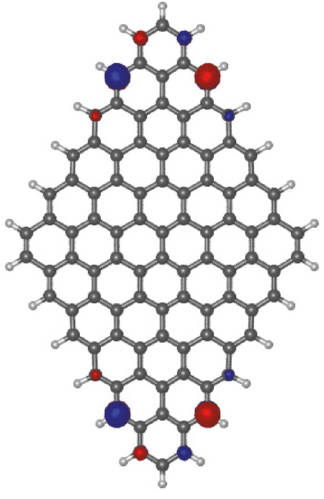
Figure 15: R 6 magnetic orbital 3.